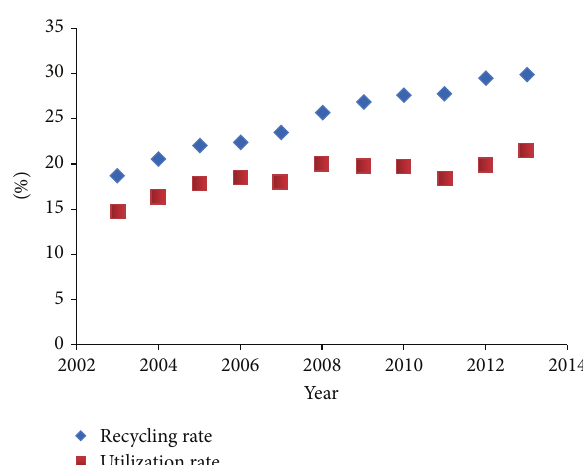
Figure 1: PET recycling and PET material utilization ratio [4].